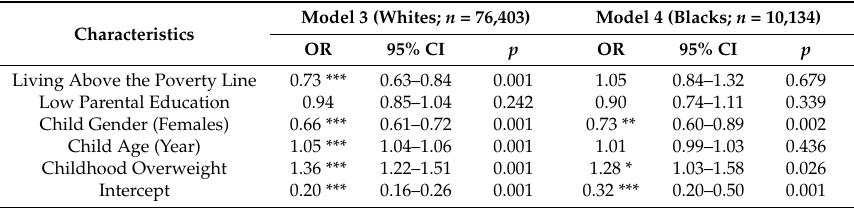
Table 4. Summary of logistic regression models by